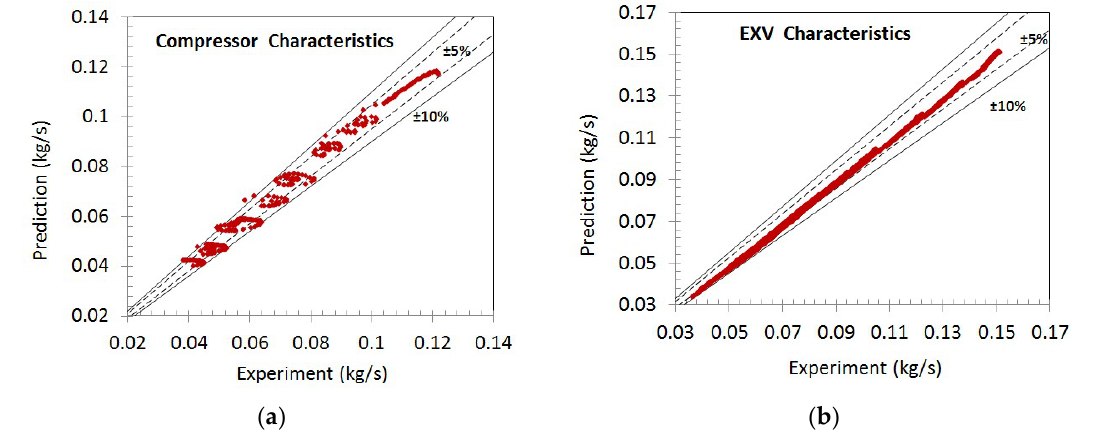
Figure 3. ( a ) Compressor; ( b ) EXV model calibration.